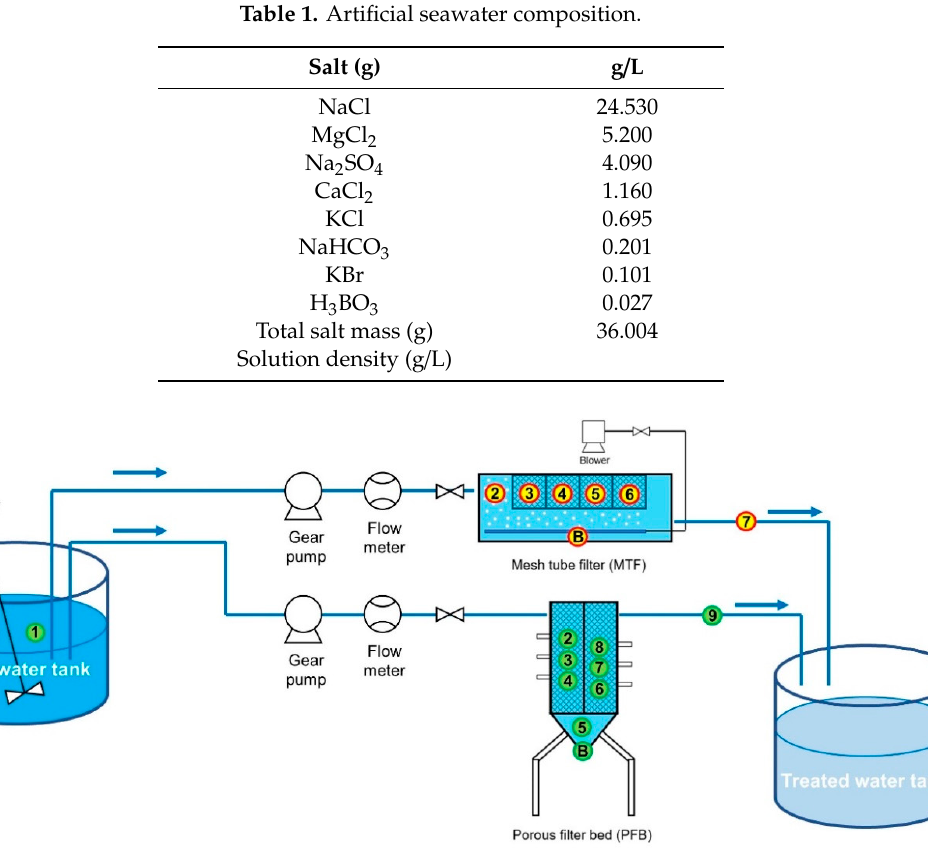
Figure 4. Characteristics of influent water during MTF and PFB field experiments (November 2019): ( a ) influent water temperature, ( b ) influent water pH, and ( c ) influent water total dissolved solids (TDS).